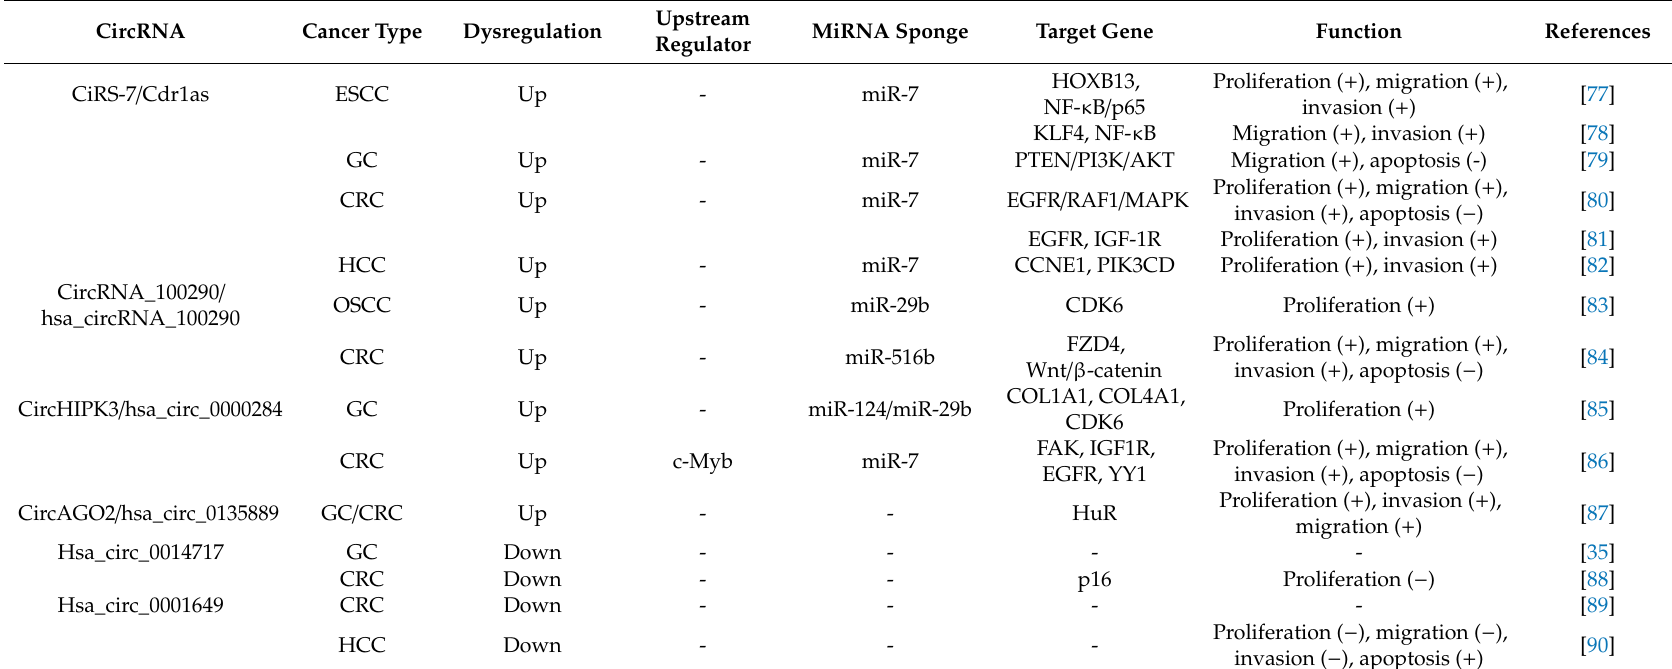
Table 4. Common circRNAs in digestive system